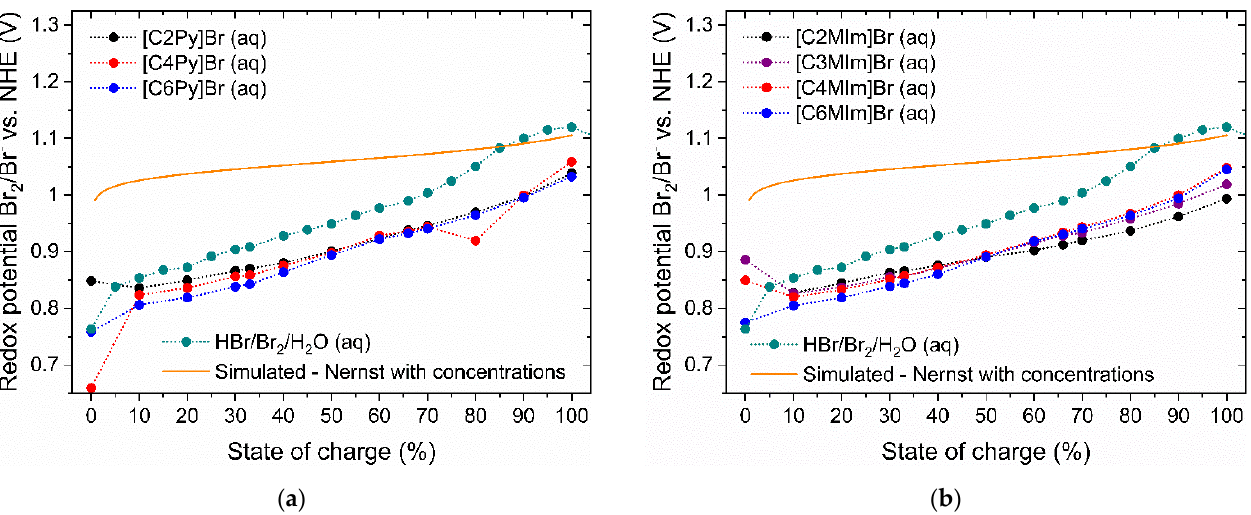
Figure 9. Redox potentials of the redox couple Br - /Br 2 in aqueous posolyte vs. NHE as a function of its state of charge SoC measured on a glassy carbon electrode without [BCA]Br and with ( a ) 1-alkylpyridine-1-ium bromides and ( b ) 1-alkyl-3-methylimidazole-1-ium bromides as BCAs with different alkyl side chain groups in the N-position of the BCA at θ = 23 ± 1 °C. The orange line shows the simulated redox potential following the Nernst equation and is based on global concentrations of HBr and Br 2 . The measured redox potential of BCA-free HBr/Br 2 electrolytes is shown with green dots for comparison and was first published in [70]. Values of redox potentials of the electrolytes containing BCAs are printed in the SM of this study in Table S8.